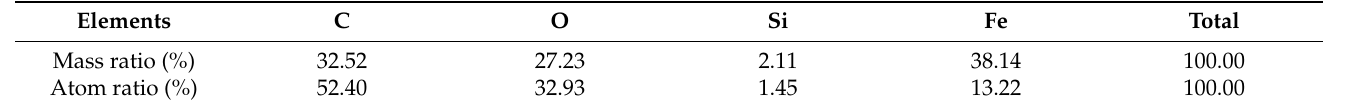
Table 2. Elemental constituents of magnetic biochar.